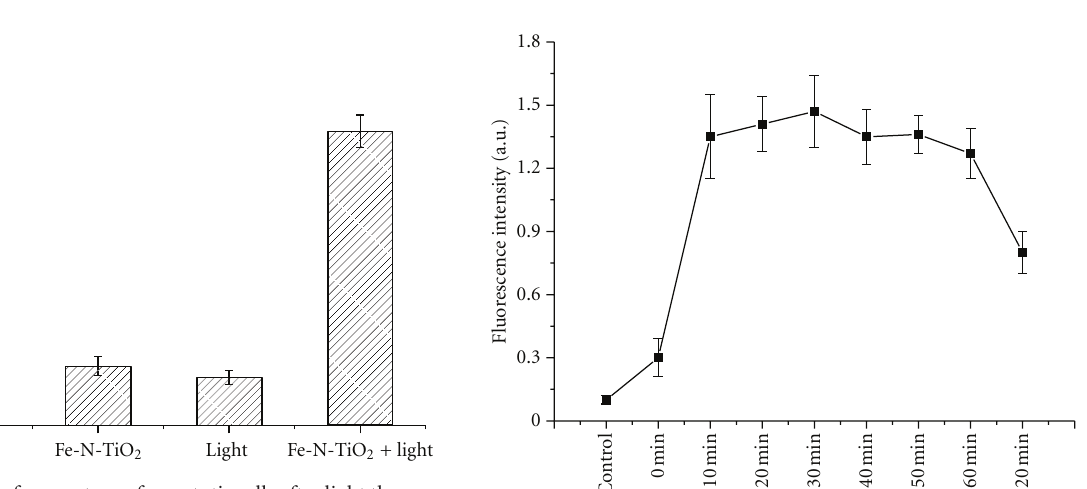
Figure 9: Alteration of Ca 2+ in HL60 cells with Fe-N-TiO 2 nano- composites during light therapy. Each data point represents mean ± SD ( n = 3). ∗ P < 0 .